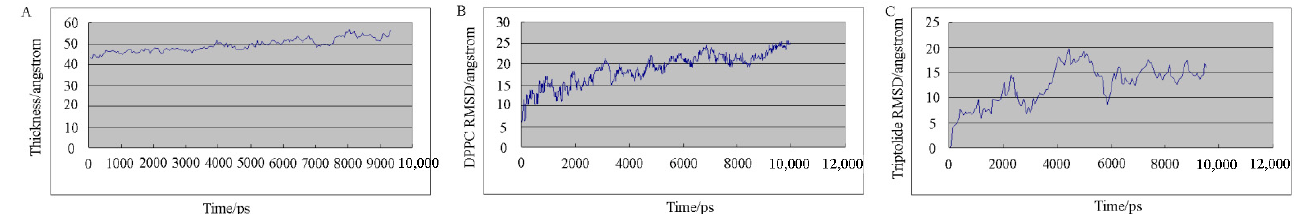
Figure 5. The simulation analysis results of the new system containing a DPPC biofilm and trip ‐ tolide: ( A ) thickness; ( B ) RMSD of DPPC biofilm; ( C ) RMSD of triptolide. ( A ) thickness; ( B ) RMSD of DPPC biofilm; ( C ) RMSD of